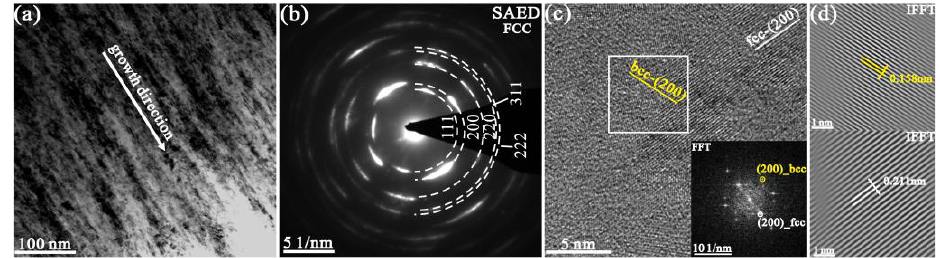
Figure 3. ( a ) TEM bright-field image, ( b ) SAED pattern, ( c ) HRTEM micrograph with FFT pattern, and ( d ) IFFT pattern of as-deposited Ti 0.84 Si 0.09 W 0.07 N